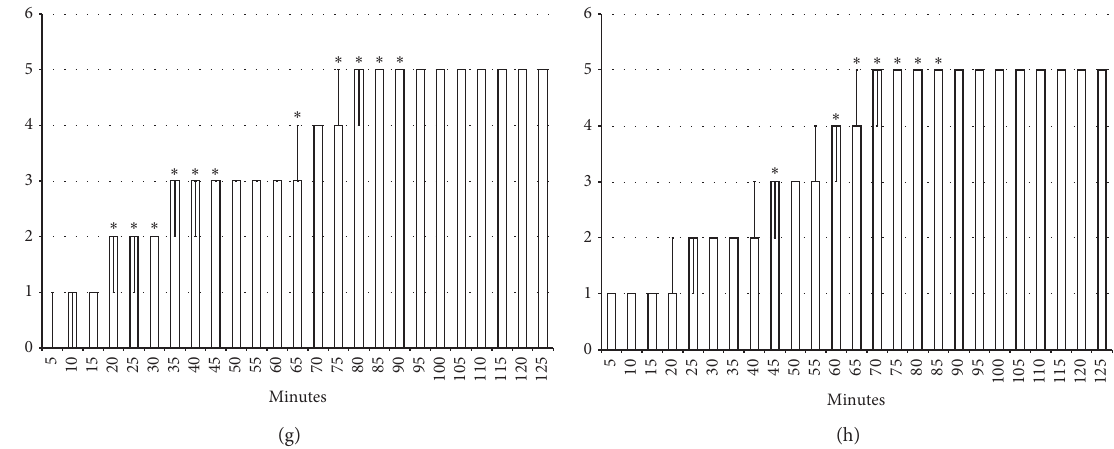
Figure 4: Axillary block (function failure): left brachial plexus perineural anesthesia (white bars) produced considerable and long-lasting function failure of the affected fore limb and an inability to walk and to grasp. The prophylactic effect of the agents given immediately after lidocaine, saline 5ml/kg, BPC 157 10 μ g/kg, L-NAME 5mg/kg, and L-arginine 100mg/kg intraperitoneally, alone and/or together. Perineural anesthesia of the nerves of the left brachial plexus, scored 0–5. (a) Saline (control). (b) L-NAME +L-arginine. (c) BPC 157. (d) L- arginine+BPC 157. (e) L-NAME. (f) L-NAME+BPC 157. (g) L-arginine. (h) L-NAME+L-arginine +BPC 157. Values are presented as min/med/max. ∗ P < 0 . 05 at least vs .